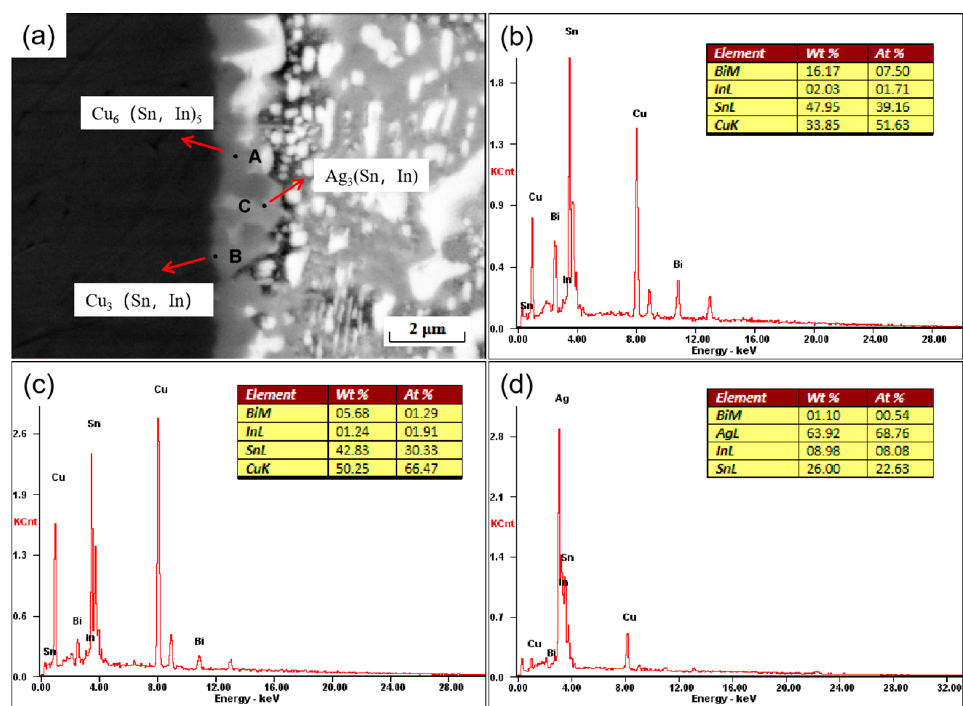
Figure 8. Interface of SnBiAg–1.5In/Cu solder joints: ( a ) microstructure and ( b ) EDS analysis of zone A, ( c ) zone B, and ( d ) zone C.